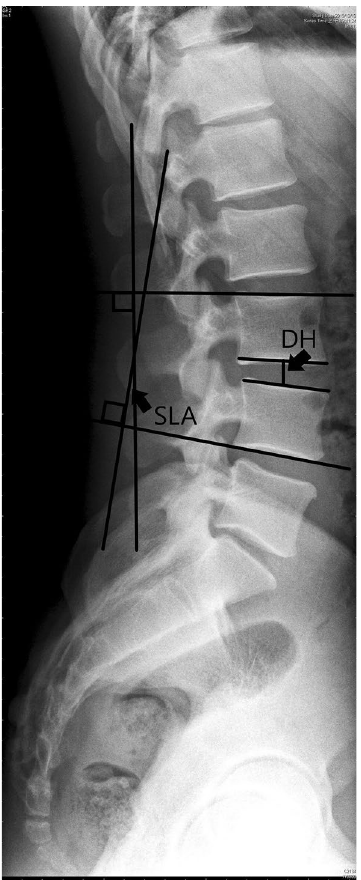
Figure 3. The lumbar spine lateral view image of a patient without any underlying disease was used to demonstrate how the segmental lordotic angle and disc height were measured. Segmental lordotic angle (SLA) is defined as the angle subtended by the superior endplate line of upper vertebral body and the lower endplate of lower vertebral body. Disc Height (DH) is defined as the distance from mid-position of upper endplate to lower endplate of two vertebral